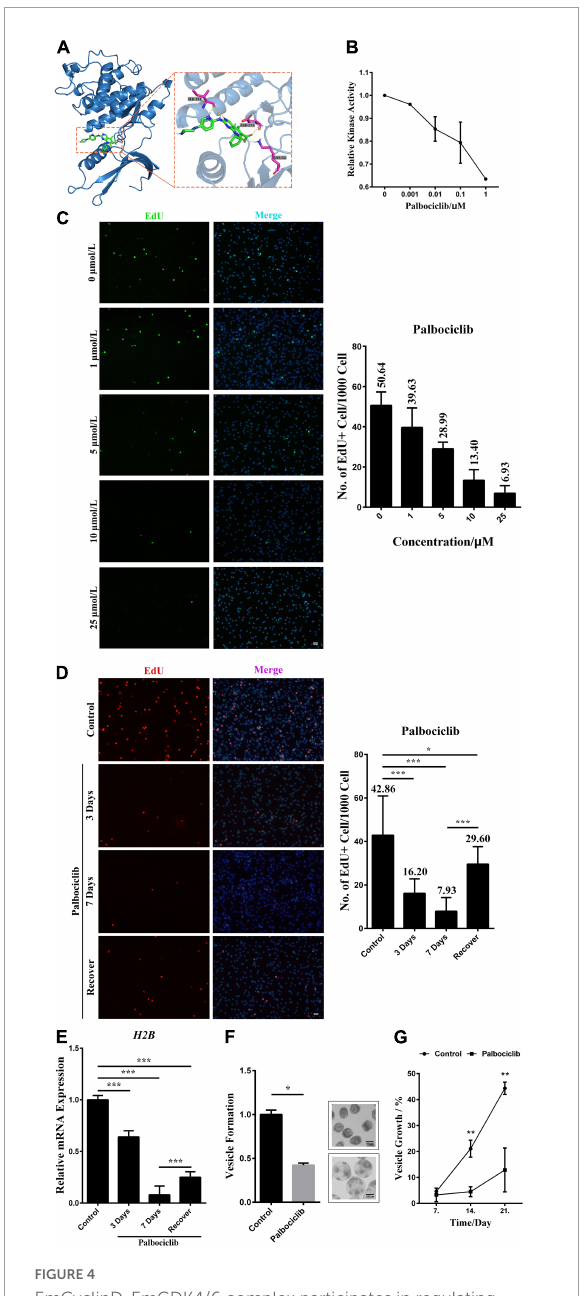
FIGURE4 EmCyclinD-EmCDK4/6 complex participates in regulating germinative cell proliferation in E. multilocularis. (A) Docking structure and interactions between EmCDK4/6 and Palbociclib. The left shows that Palbociclib binds to the ATP binding pocket of EmCDK4/6. The right shows the details of the EmCDK4/6-Palbociclib interaction. (B) In vitro kinase assay of EmCyclinD-EmCDK4/6 complex with Palbociclib. Data are shown as mean ± SD of duplicate. (C) 3 days effects of different concentrations of Palbociclib on germinative cell proliferation. Representative images are shown in the left panel, Bar = 50 µ m. Quantification of EdU + cells is shown in the right panel. Data are shown as mean ± SD of 2 separate labeling experiments. EdU detection was performed using green fluorophore (Alexa Fluor 488). (D) Proliferation recovery after 7 days of 10 µ M (Continued)